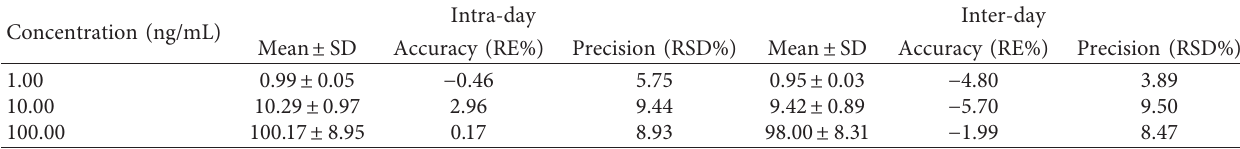
Table 2: Precision and accuracy for intra-day and inter-day of TMEA ( n � 6).